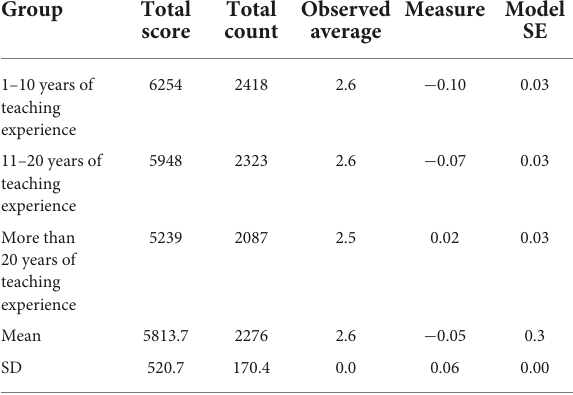
TABLE 10 Teachers’ differences in severity based on teaching experience.